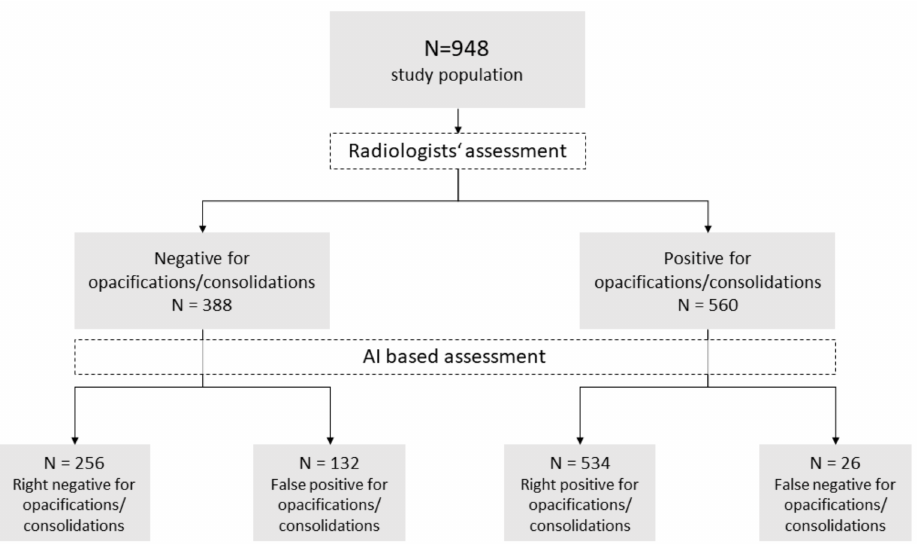
Figure 4. Performance of the artificial intelligence in detecting pneumonia in chest radiographs. Performance of the artificial intelligence in detecting pneumonia in chest radiographs with the radiologists’ assessment as reference standard.